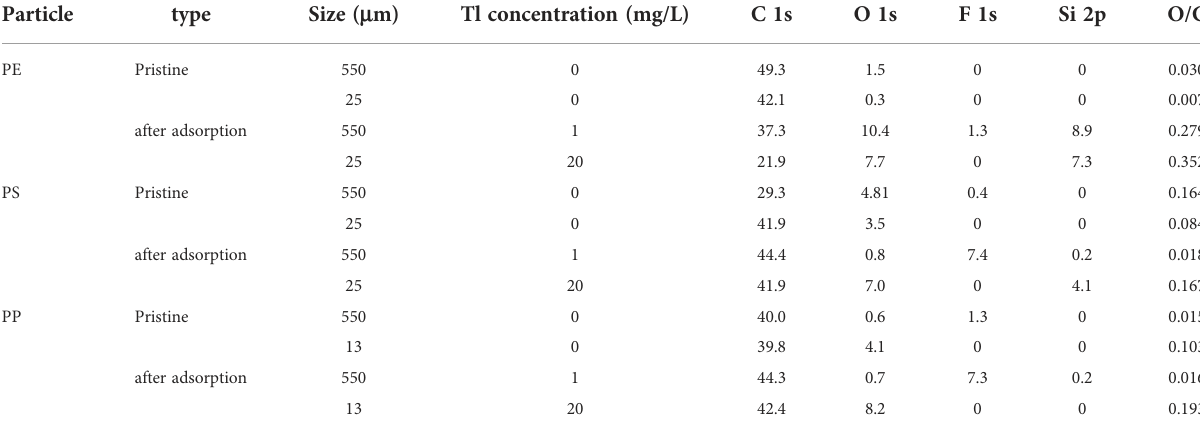
TABLE 1 Atomic percentages (%) for the elements on the particle surfaces before and after Tl adsorption in the kinetic adsorption a